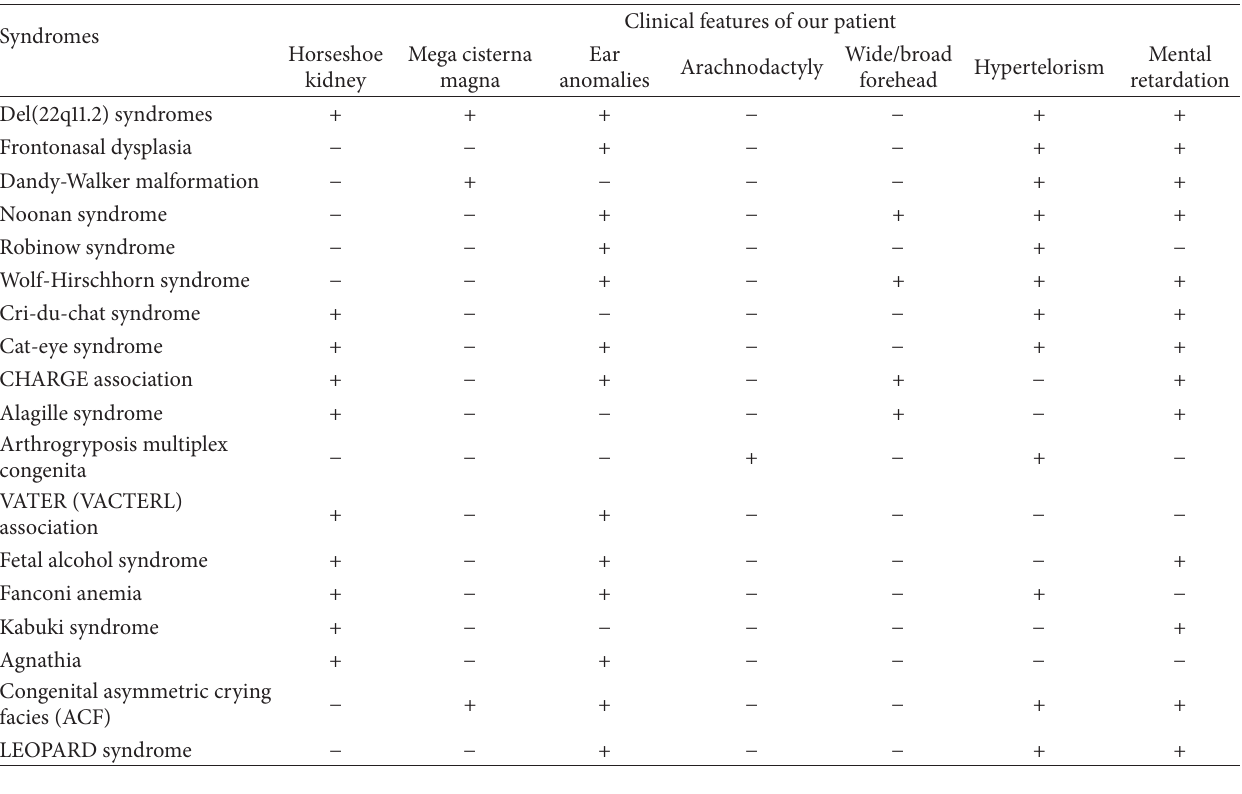
Table 1: Defined syndromes partially including clinical features of our patient.